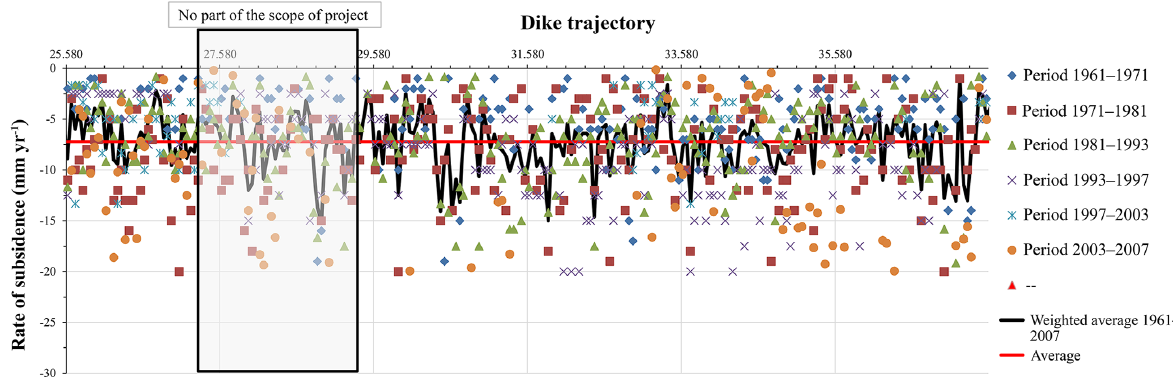
Figure 2. Determination of average subsidence rate based on HHSK archive data.